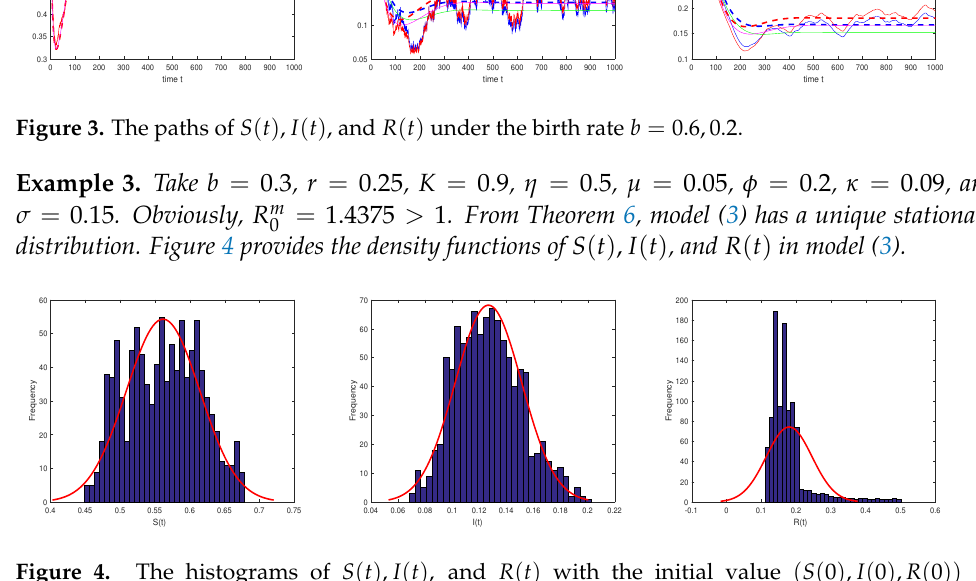
Figure 4. The histograms of S ( t ) , I ( t ) , and R ( t ) with the initial value ( S ( 0 ) , I ( 0 ) , R ( 0 )) = ( 0.6,0.2,0.5 )